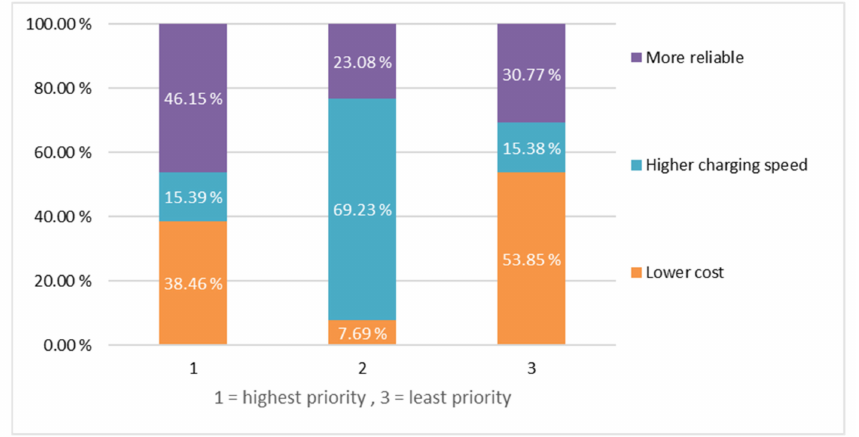
Figure 2. Ranking of the infrastructure